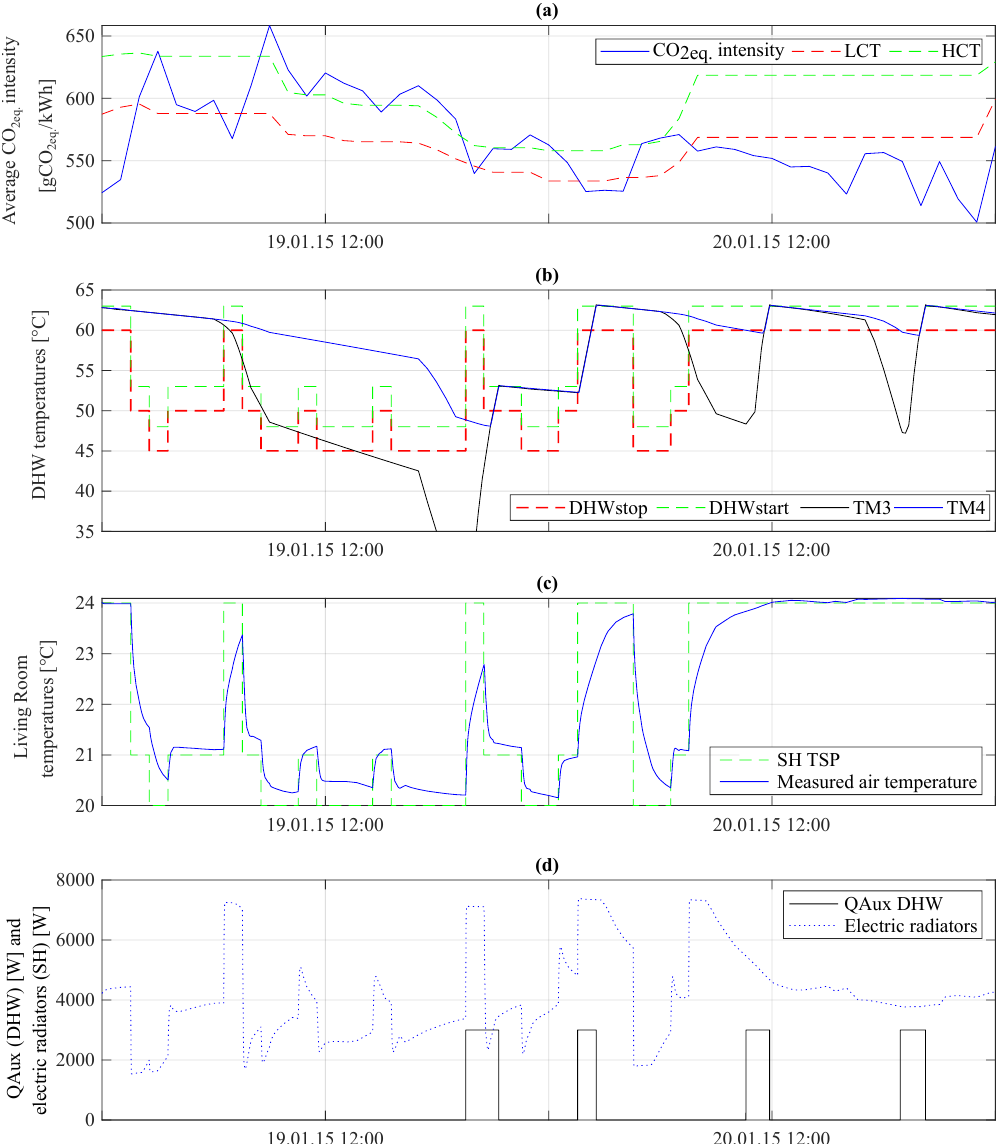
Figure 6. Illustration of the control principle for DK1 case CSC-a during a 48 h period, where ( a ) shows the CO 2eq. intensity, ( b ) shows the DHW temperatures and hysteresis set-points, ( c ) shows the measured air temperature and the temperature set-point for space heating and ( d ) shows the power of the electric radiators and the electric auxiliary heater (DHWstart and DHWstop are the start and stop temperatures for DHW; TM is two temperature measurements in the water tank; SH TSP is space heating temperature set-point; QAux is the electric resistance